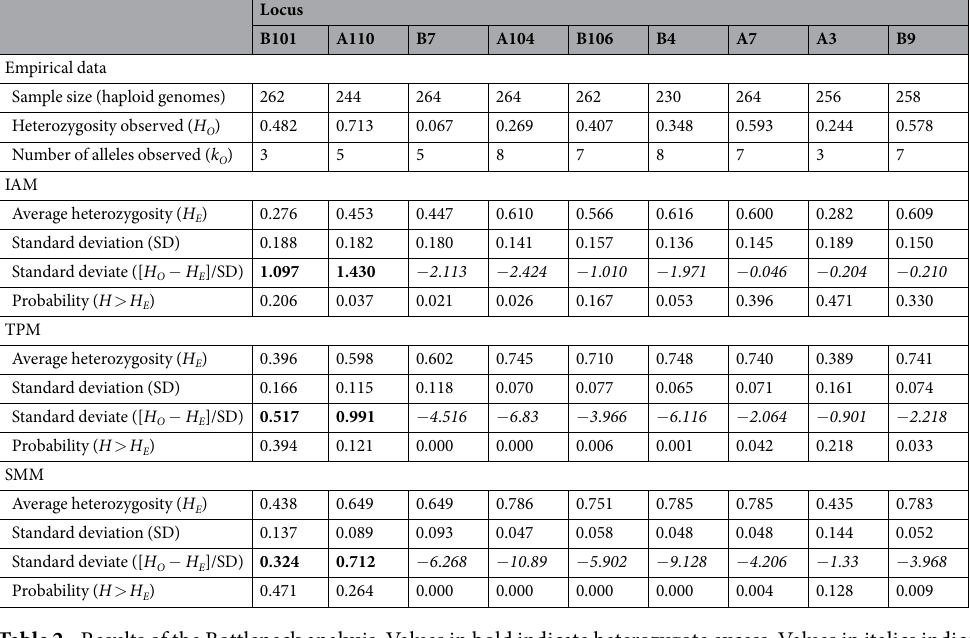
Table 2. Results of the Bottleneck analysis. Values in bold indicate heterozygote excess. Values in italics indicate heterozygote deficiency.